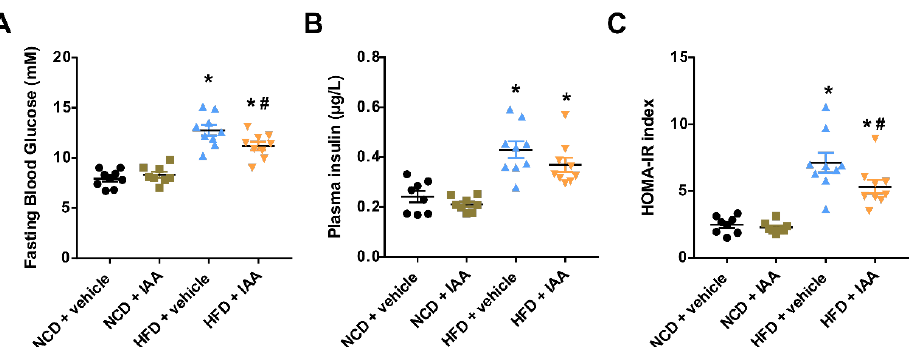
Figure 1. Indole-3-acetic acid (IAA) protected against high-fat-diet (HFD)-induced insulin resistance in mice. ( A ) Fasting blood glucose levels determined by a glucometer in mice fasted overnight. ( B ) Results from ELISA for plasma insulin. ( C ) HOMA-IR calculated as described in the Materials and Methods section. Data are expressed as the mean ± standard error of the mean. n = 8 – 9. * p < 0.05 vs. NCD + vehicle; # p < 0.05 vs. HFD + vehicle.